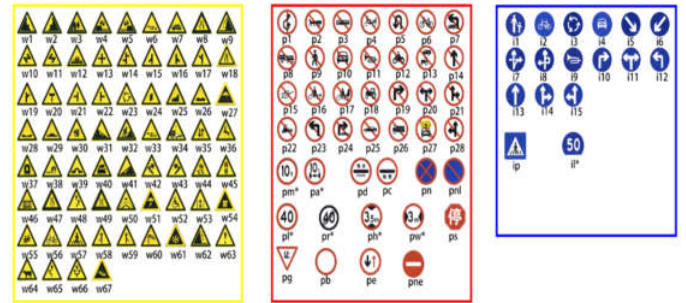
Figure 10. TT100K category.